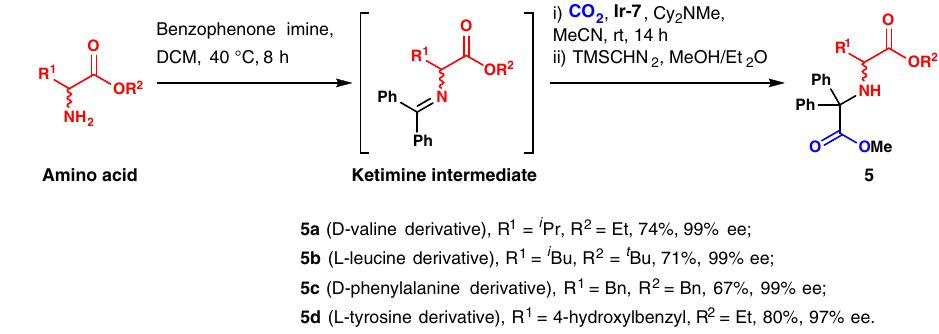
Fig. 5 Further synthetic applications. Synthesis of enantioenriched iminodiacetic acid derivatives from α -amino acid